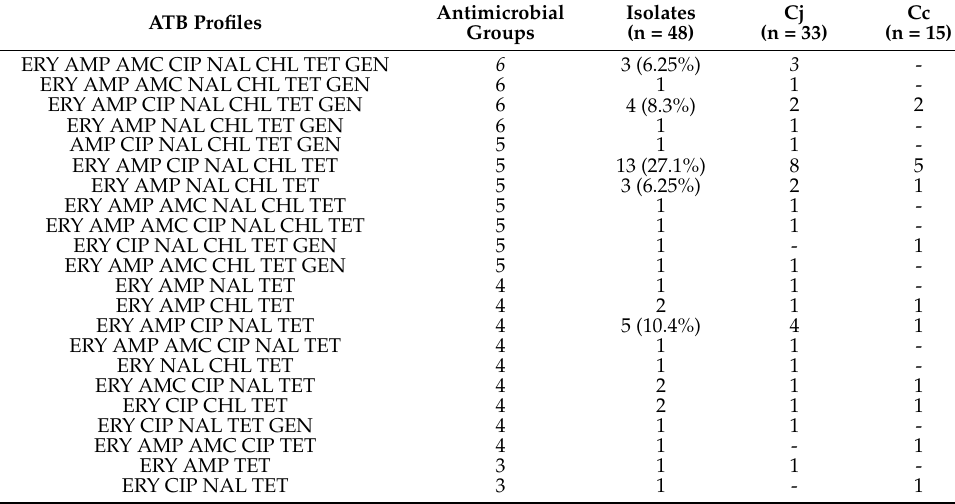
Table 3. MDR patterns of C. jejuni and C. coli isolates from chicken carcasses. ATB